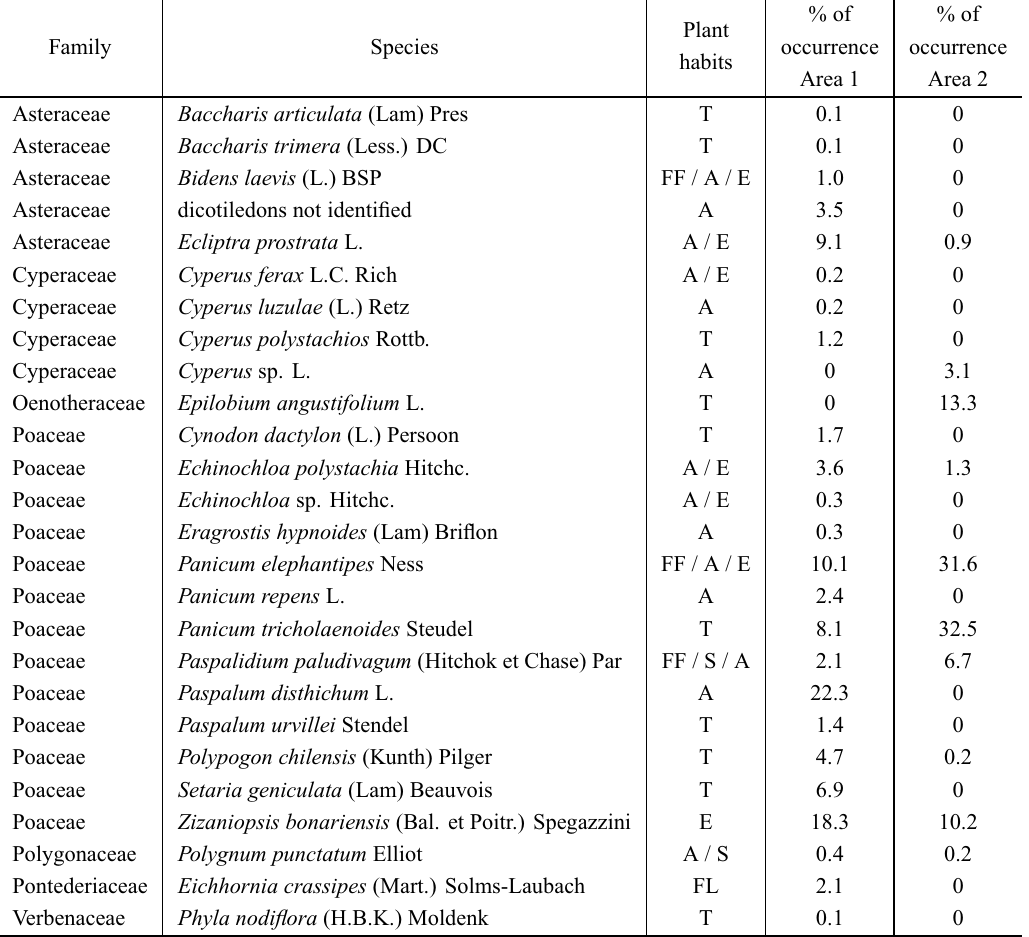
Species of plants identified in coypu’s feces ( Myocastor coypus ) from both areas (Area 1 – Santa Isabel do Sul wetlands; Area 2 – Santa Marta Farm), its habit and percentage of annual occurrence. A = amphibious, E = emergent, FF = floating fasten, FL = floating free, S = submersed and T =